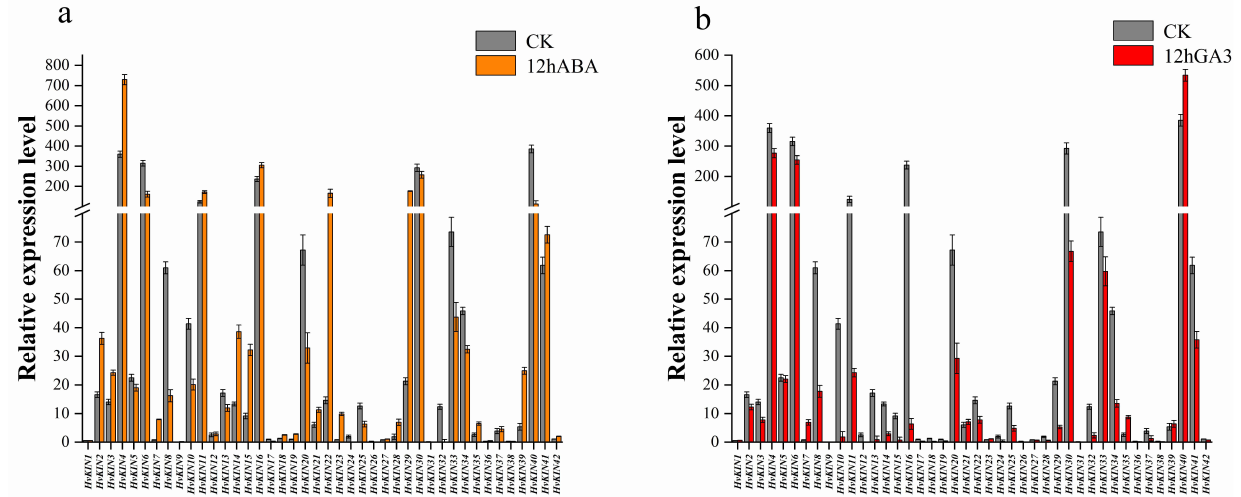
Figure 10. Gene expression analysis of HvKINs after ABA and GA3 treatment. The data summarized at least three biological replicates. ( a ) HvKINs gene relative expression in barley after 12 h of ABA treatment. Orange represents the ABA therapy group, while gray represents the control group. ( b ) Relative expression of HvKINs genes in barley following a 12-h GA3 treatment. Red represents the GA3 treatment group and gray served as the control group.